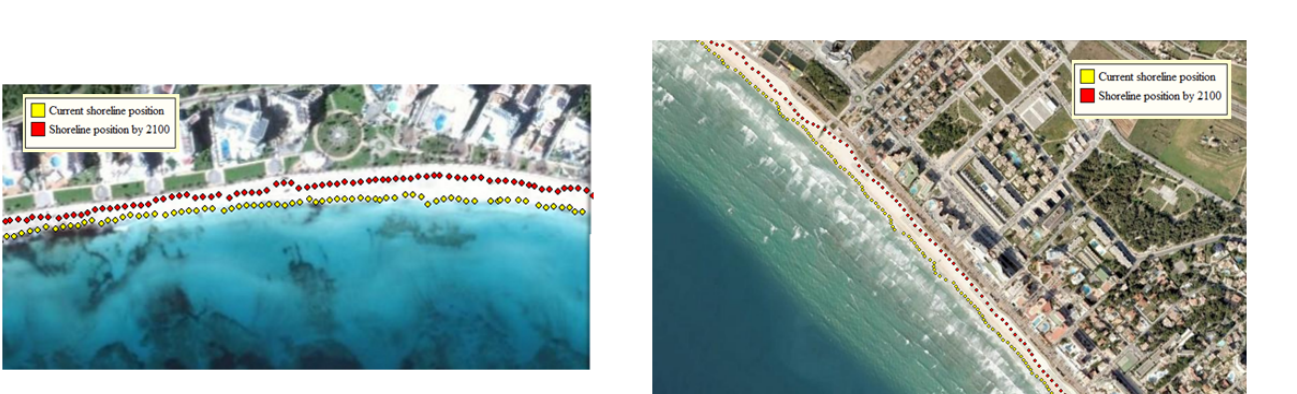
Figure 17. Present-day shoreline position (in black) and landward migration (in red) in the worst case scenario (mean sea level rise under RCP85 and extreme wave conditions) by the end of the 21st century in the Cala Millor beach.